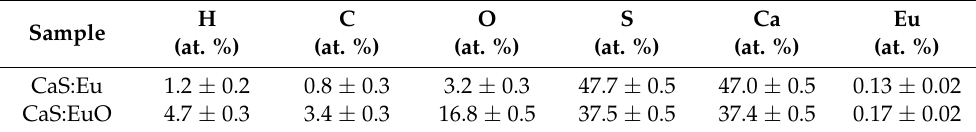
Figure 5. Depth profile of ( a ) CaS:Eu and ( b ) CaS:EuO samples. Dashed vertical lines indicate the depth range used for elemental compositional analysis. Table 2. Elemental composition of the CaS:Eu and CaS:EuO samples measured with